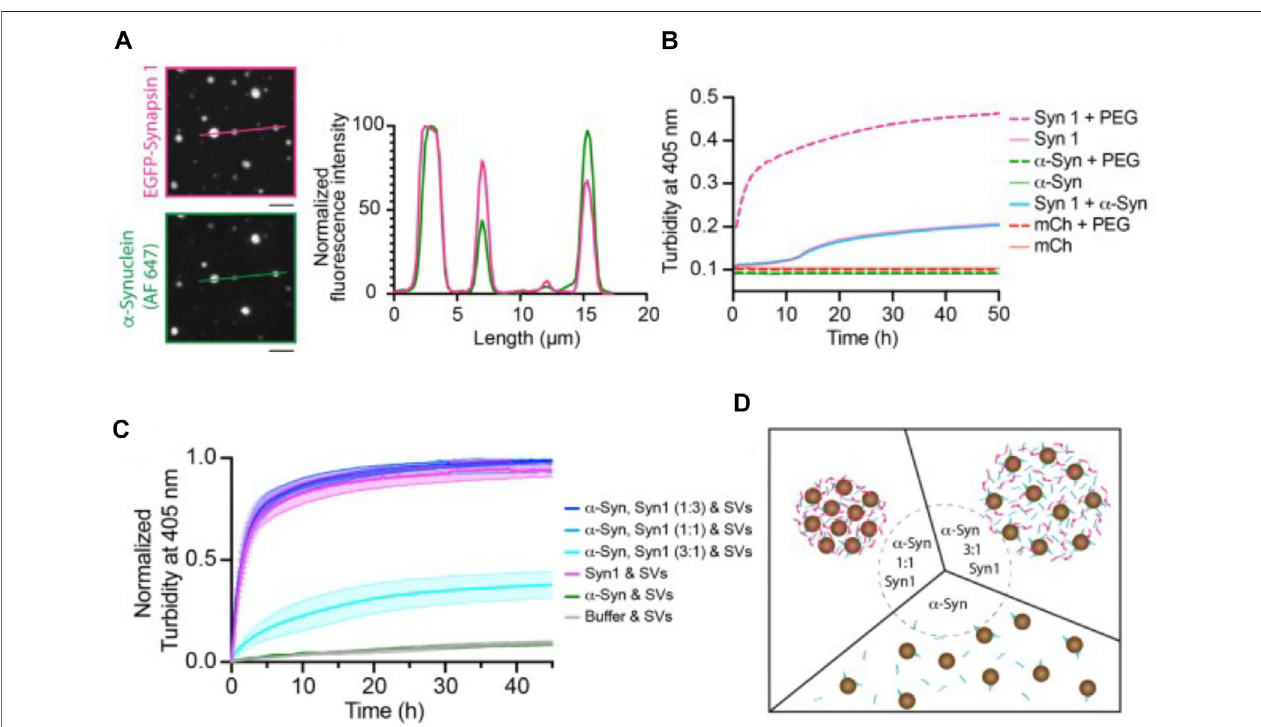
FIGURE 2 | Synapsin recruits α -synuclein into liquid protein droplets but α -synuclein is not able to drive phase separation effectively and recruit synaptic vesicles into the liquid droplets. (A) Colocalization of reconstituted condensates containing EGFP-Synapsin 1 (6 µM) and α -synuclein (2 mM, chemically labeled with Alexa Fluor 647, AF 647) in 3% PEG, 8,000. Scale bars, 5 µm. (B) Condensate formation of puri fi ed recombinant proteins. 6 µM EGFP-synapsin one in magenta; 6 µM mCherry in red;2 µM α -synucleiningreenintheabsence(fullline)orpresenceof3%PEG8000(dashedline).Thecondensateformationwasmeasuredasachangeinturbidity at 405 nm. (C) Excess of α -synuclein reduces the rate of synapsin condensate formation, and α -synuclein is unable to recruit SVs. Condensate formation of puri fi ed recombinantproteinsEGFP-synapsinIand α -synucleinindifferentmolarratios(curvesintonesofblue),EGFP-synapsinonealone(magenta), α -synucleinalone(green)in presence of 23 nM SVs. The condensate formation was measured asa change in turbidity at 405 nm. Each value is shown as the average ±standard error of the mean, dataarefromthreeindependentreplicates(eachtimefreshisolationofnativeSVs). (D) Schemeofthesynapsin/SVcondensationinthepresenceofdifferentmolarratios of α -synuclein ( α -synuclein-to-synapsin, 1:1 left and 3:1 right) or in the absence of synapsin (bottom). From (Hoffmann et al.,